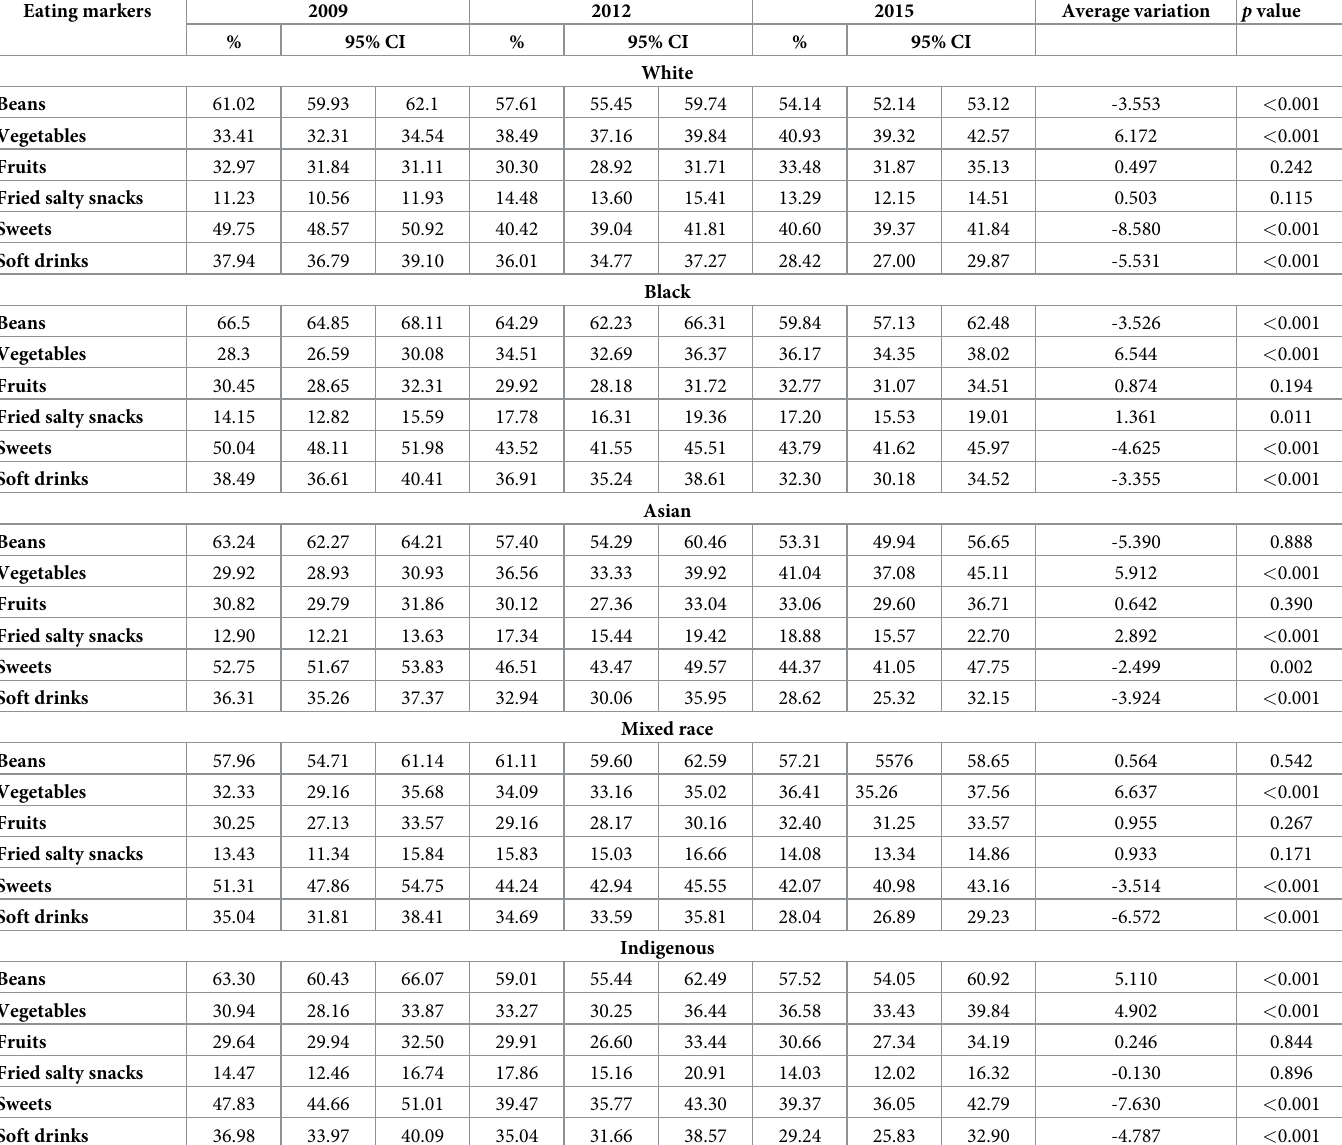
Table 4. Trends in prevalence of regular food consumption ( � 5 times/ week) of diet markers, according to race/skin color, from 2009 to 2015. Brazil, 2009, 2012 and 2015. Eating markers